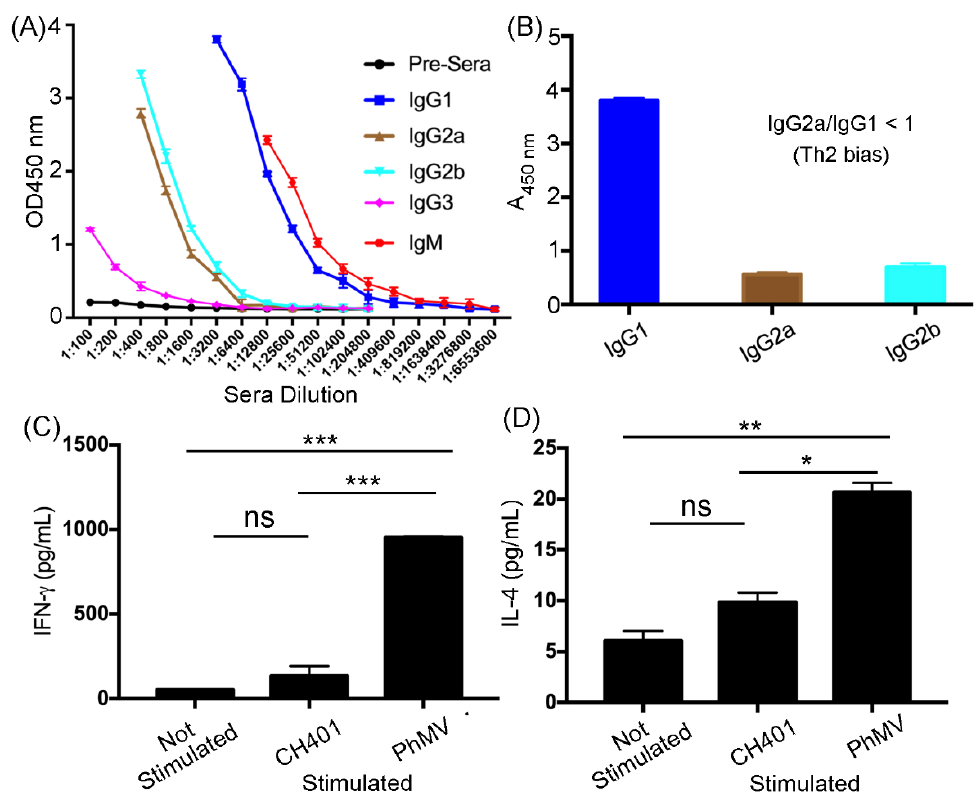
Figure 3. The antibody subtypes and cytokines response from the immunized mice. ( A ) Immunoglobulin subtyping of the sera collected from the PhMV-CH401 group against the CH401 peptide by ELISA. ( B ) IgG1/IgG2a/IgG2b isotypes of the pooled sera at 1:3200 dilution against the CH401 peptide. ( C ) IFN- γ and IL -4 ( D ) secretion from splenocytes isolated from immunized mice, with (stimulated) and without (not stimulated) exposure to CH401 peptide and unmodified PhMV VLPs (20 μg/mL, 18 h). Means of triplicates and standard deviations are shown. Statistical analysis between stimulated and unstimulated cells in each group by two-way ANOVA, with Tukey’s test: ns = not significant; * p < 0.05; ** p < 0.01; *** p < 0.001.